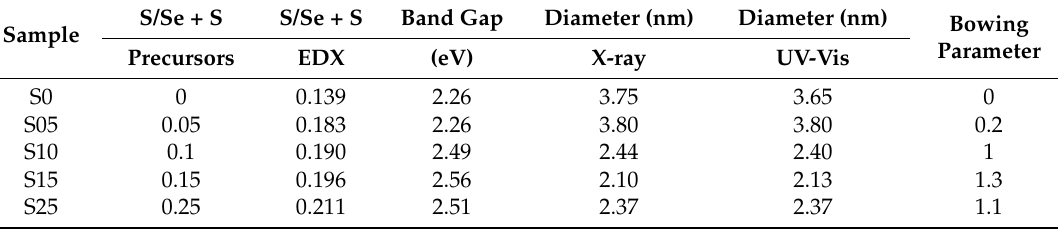
Figure 1. EDX spectra for the CdSe 1− x S x nanostructures with different content of sulfur. ( a ) x = 0.0 (S0 sample); ( b ) x = 0.05 (S05 sample); ( c ) x = 0.1 (S10 sample); ( d ) x = 0.15 (S15 sample); ( e ) x = 0.25 (S25 sample). Table 1. Band gap and size of the quantum dots using different techniques for CdSe and CdSe doped with different S contents.